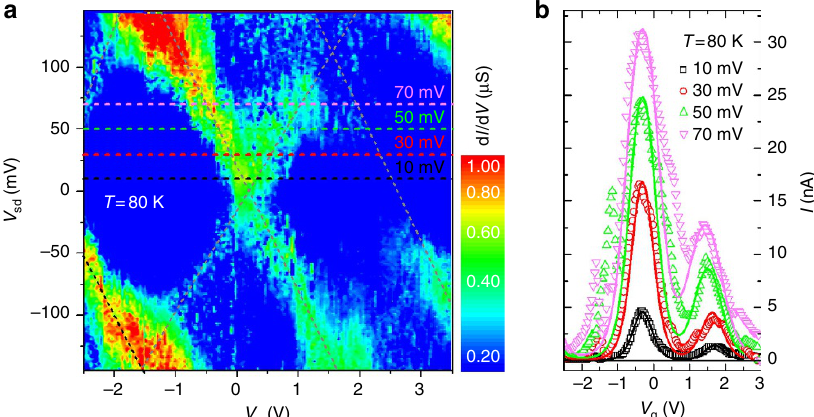
Figure 2 | Charge transport at 80K. ( a ) Differential conductance of a junction with S-(CH 2 ) 4 -Fc-(CH 2 ) 4 -S at T ¼ 80K. The colour code represents the conductance (d I/ d V ) through the SET as a function of V sd and V g . The grey dashed lines indicate the main resonant excitations, crossing at two visible charge degeneracy points at V sd ¼ 0 (that is, V g ¼ 0.25 and 2.5V) and separating the Coulomb blockade areas. A third charge degeneracy point is estimated to lie around (cid:2) 3.5V. ( b ) Current versus gate voltage for four different bias voltages (10, 30, 50 and 70mV). Symbols represent experimental values and solid lines are fits to the single-level tunnelling transport model (equation 1) using the parameters given in Table 1. The colour code corresponds to the horizontal dashed lines in a . The molecule most likely changed its conformation within the SETelectrodes between both measurements resulting in a shift in the position of the degeneracy points (new positions: V g ¼ (cid:2) 0.3 and 1.7V).